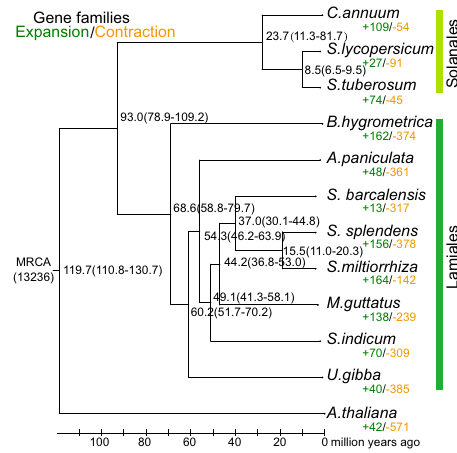
Fig. 2 Phylogenetic analysis and divergence time estimations among 12 plant species. The tree was constructed based on 379 single-copy orthologous genes using the maximum likelihood method. Divergence times (Mya) are indicated in black numbers beside the branch nodes. The number of gene-family expansion and contraction events is indicated by green and orange numbers